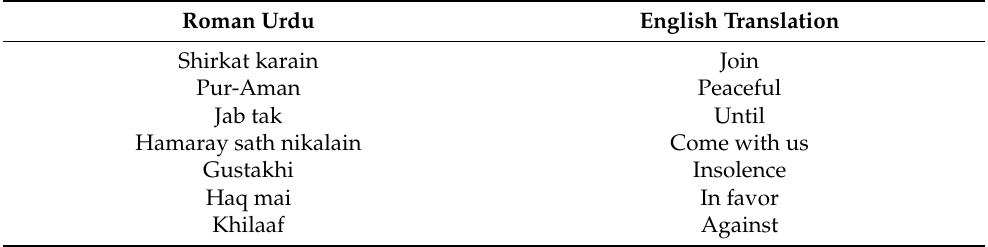
Table A2. Meaning of Roman Urdu words used in bigrams and trigrams in the English